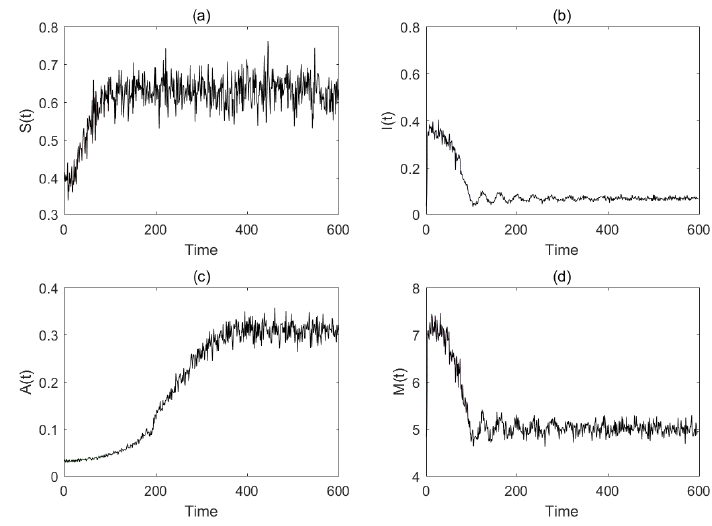
√ Figure 1. If σ i 1 ( n ) = 0.04 + 0.01 sin n , σ i 2 ( n ) = 0.1 + 0.05 sin n ( i = 1, 2, 3, 4 ) , c 1 ( u ) = 0.5, c 2 ( u ) = 0.03, c 3 ( u ) = 0.02, c 4 ( u ) = 0.05, ϑ = 0.5, then it is easy to show that (cid:101) R 1 = 0.0349, (cid:101) R 2 = − 0.0252, (cid:101) R 3 = 0.0445, (cid:101) R 4 = − 0.0273, which follows that (cid:101) R s = 0.0257 > 0. The dynamical responses S ( t ) , I ( t ) , A ( t ) , M ( t ) of system (4) with initial value ( 0.4, 0.1, 0.05, 5 ) are plotted in ( a – d ), respectively, which indicates an exponential convergence. If c 1 ( u ) = 0.4, c 2 ( u ) = 0.03, c 3 ( u ) = 0.02, c 4 ( u ) = 0.05, ϑ = 0.5, then it is easy to show that (cid:101) R 1 = 0.0426, (cid:101) R 2 = − 0.0849, (cid:101) R 3 = 0.0551, (cid:101) R 4 = − 0.0415, which follows that (cid:101) R s = 0.0176 > 0. Based on Theorem 2, one can be concluded that ( S ( t ) , I ( t ) , A ( t ) , M ( t ) , n ) of system (4) is f -exponentially ergodic. The dynamical responses S ( t ) , I ( t ) , A ( t ) , M ( t ) of system (4) with initial value ( 0.35, 0.15, 0.04, 5 ) are plotted in Figure 2a, Figure 2b, Figure 2c, Figure 2d, respectively, which indicates an exponential convergence.